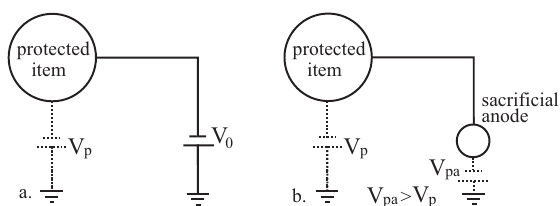
Figure 1: Cathodic protection. a. Active protection. V V where V is the contact potential of the protected item p p (iron). b. Passive cathodic protection. The sacrificial metal provides the potential V electrons from the protected item provided V